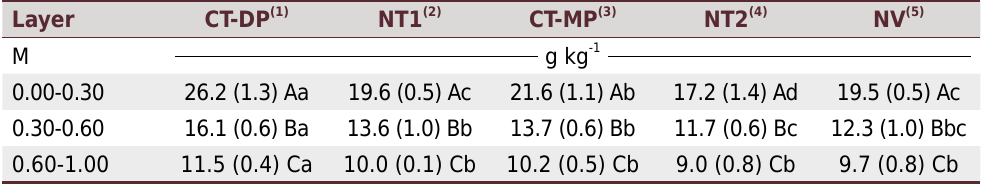
Layer CT-DP (1) NT1